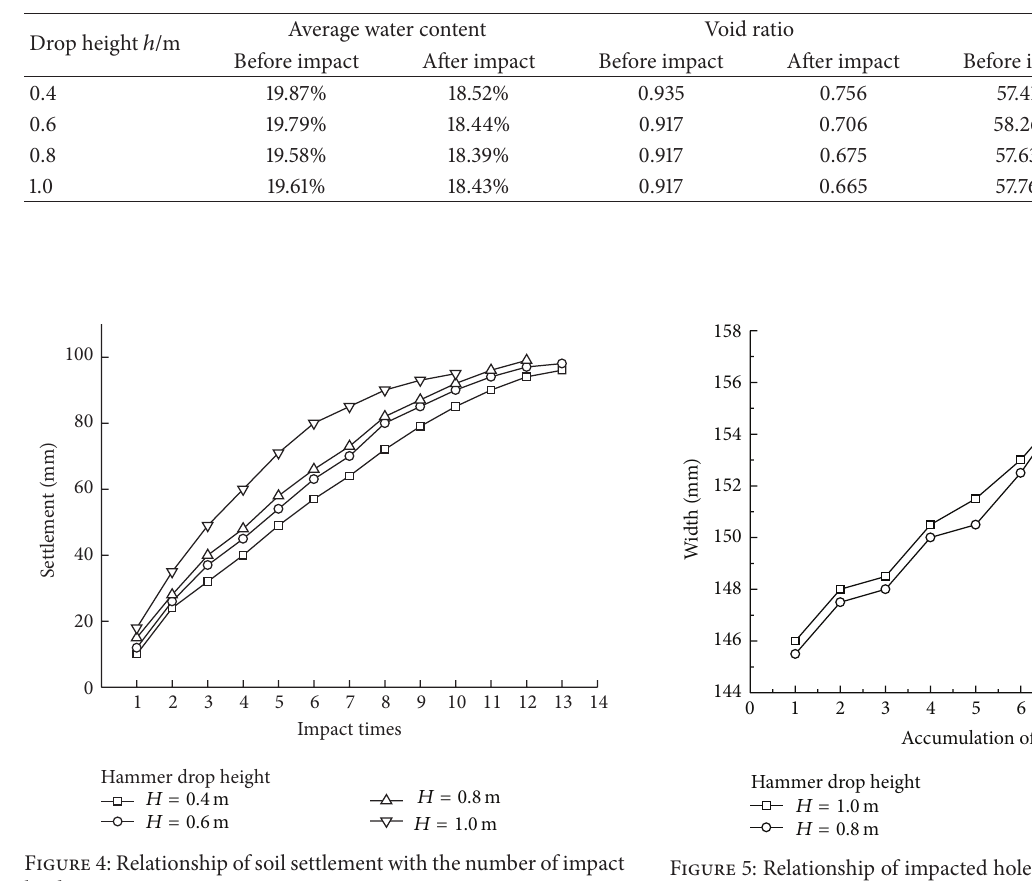
Figure 5: Relationship of impacted hole width with the number of impact